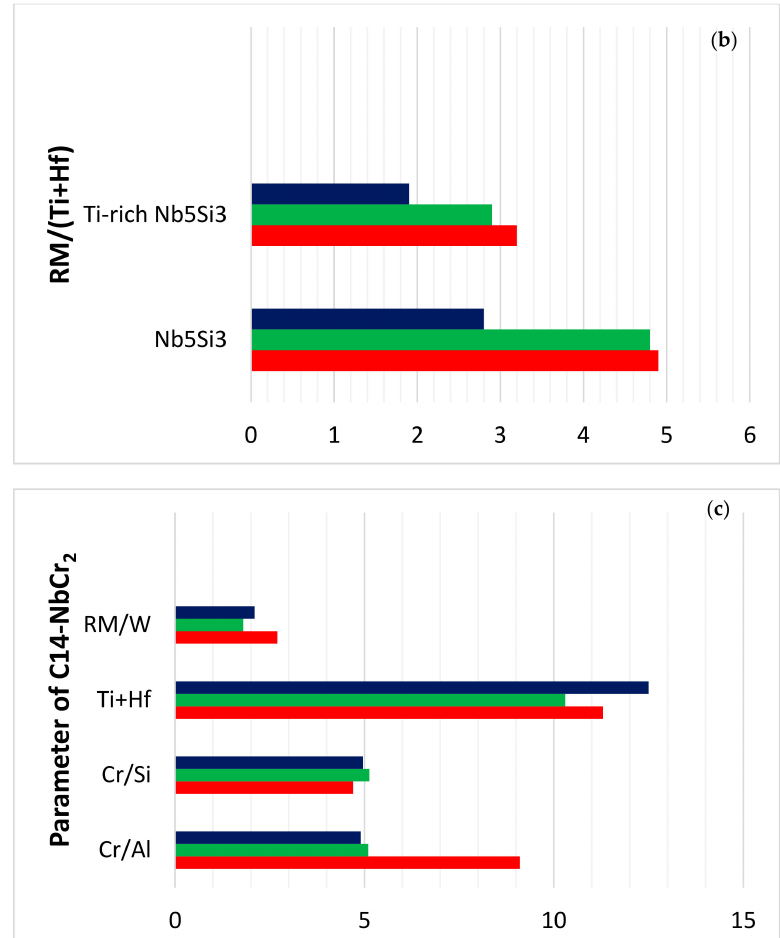
Figure 10. Parameters of di ff erent phases for the bulk of oxidised specimens at 800 ◦ C, red JZ3, green JZ4, blue JZ5. ( a ) Data for A15-Nb 3 X, parameters < Si > (at.%), RM / W, concentration of Ti (at.%), ( b ) data for Nb 5 Si 3 , parameter RM / (Ti + Hf), ( c ) data for C14-NbCr 2 , parameters Cr / Al, Cr / Si, Ti + Hf, RM / W. RM = Mo or Ta, < Si > = Al + Ge + Si +